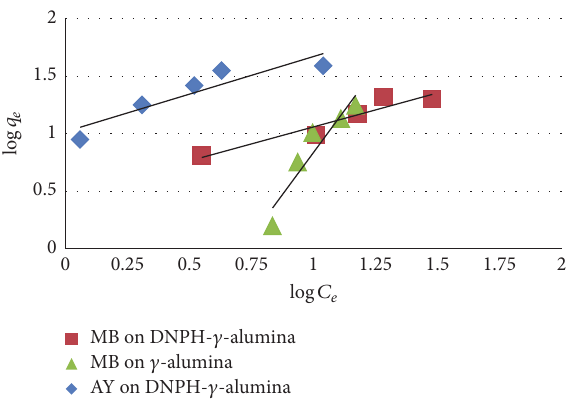
Figure 12: Freundlich isotherm plots for adsorption of AY an MB on 𝛾 -alumina and DNPH- 𝛾 -alumina.